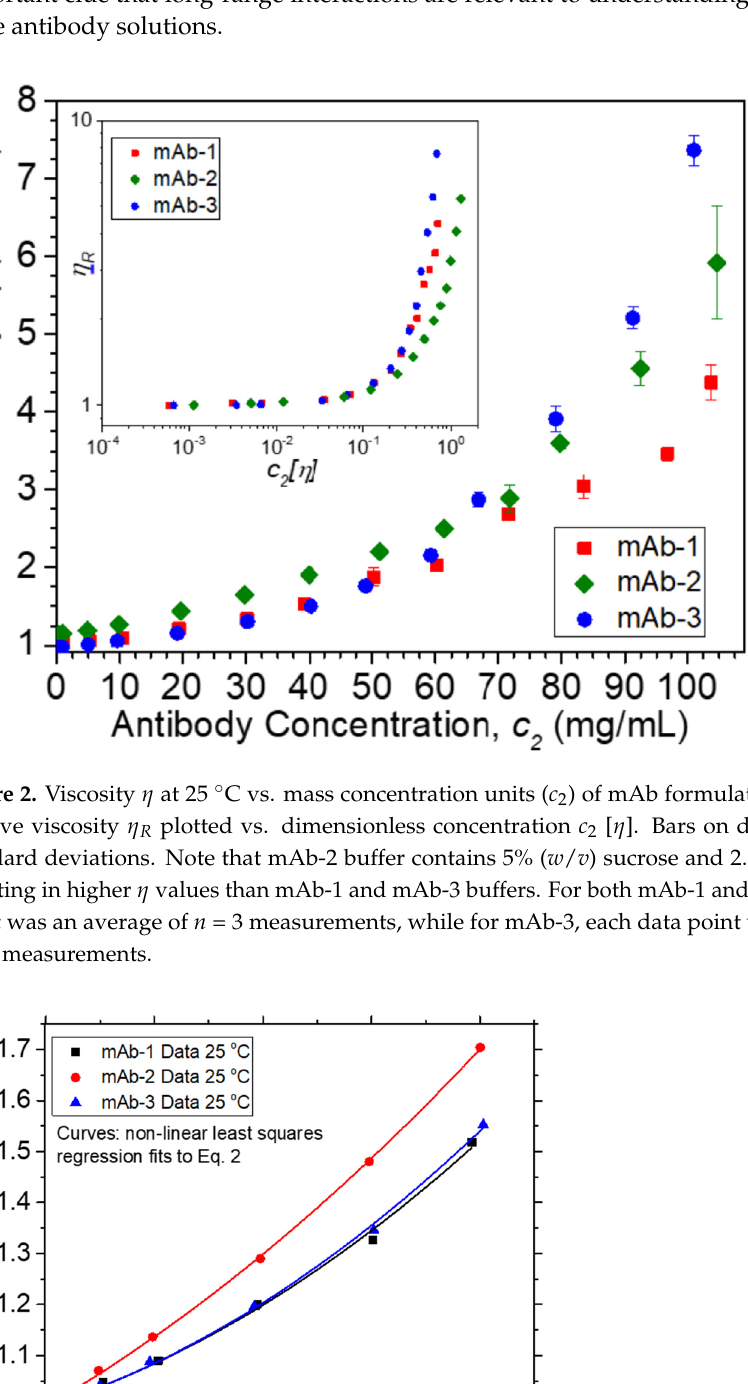
Figure 3. Relative viscosity η R at 25 °C vs. mass concentration units ( c 2 ) of Vaccine Research Center (VRC) mAbs. Points and curves denote data and non-linear least squares regression fits to Equation (2), respectively. R 2 , values for fits to mAb-1, mAb-2, and mAb-3 data are 0.999, 0.992, and 0.999, respectively. Table 3. Experimentally determined values of Huggins coefficient k H , intrinsic viscosity [ η ], and osmotic second virial coefficient B 22 at 25 °C for mAbs.